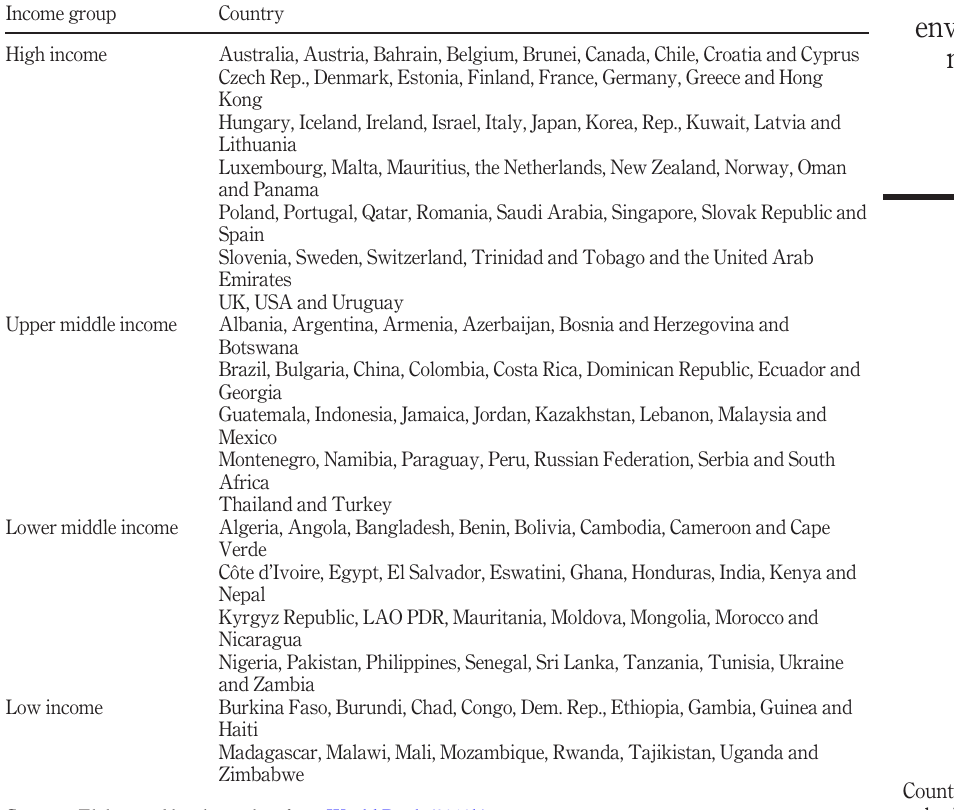
Table 1. Countries